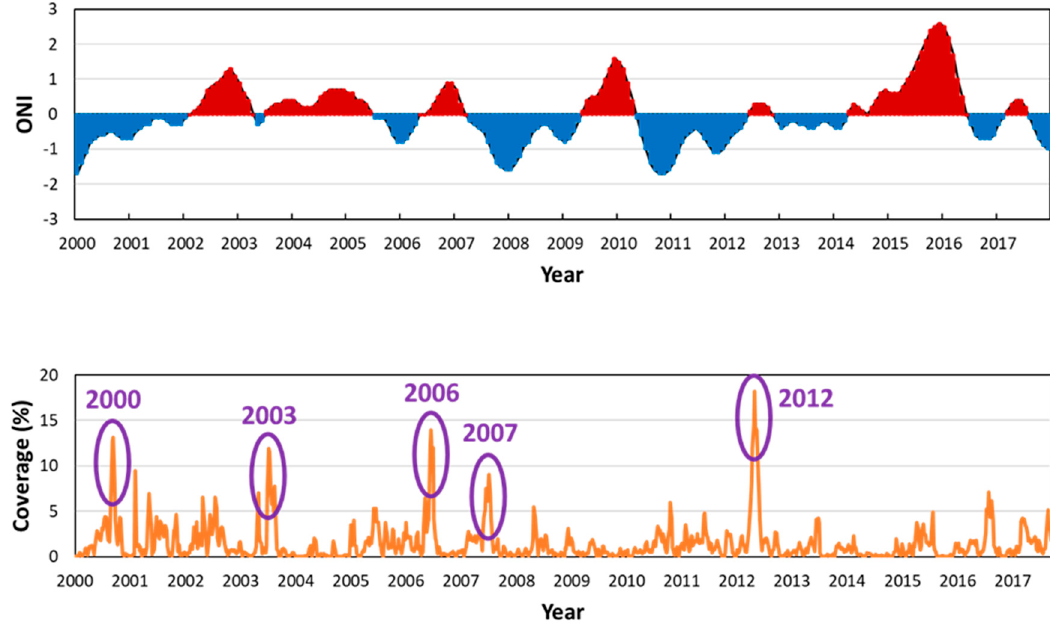
Figure 5. Time series of the National Oceanic and Atmospheric Administration’s Oceanic Nino Index ( top ) and flash drought coverage over the contiguous United States ( bottom ) from 2000 to 2017.